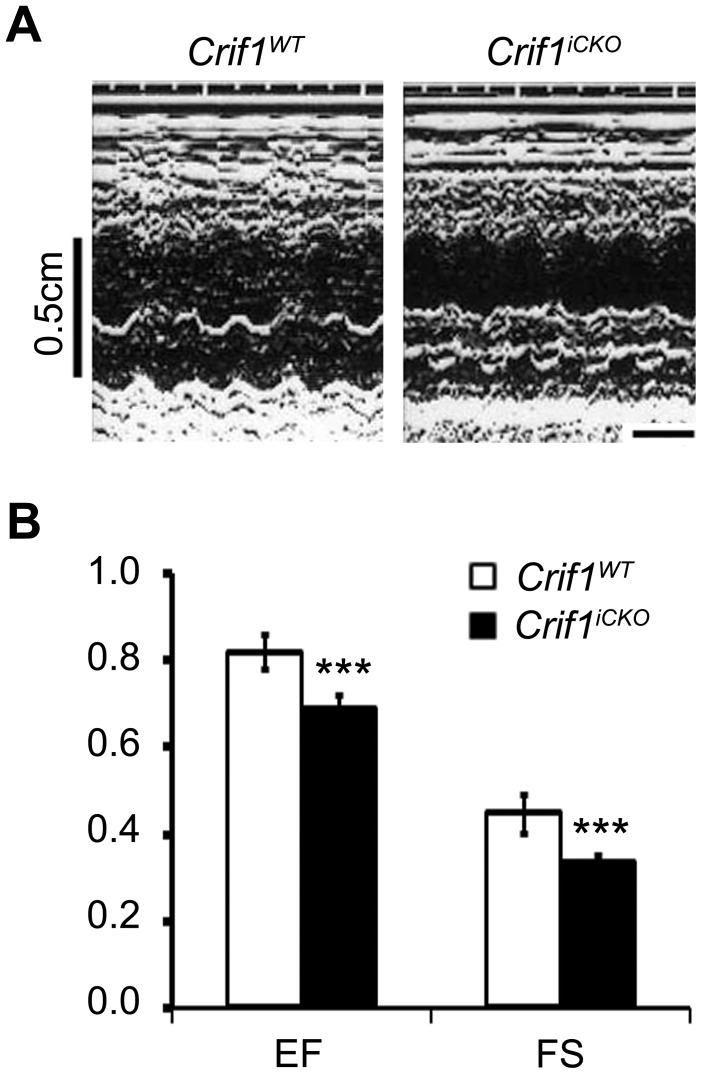
Crif1 loss impairs in vivo heart function.(A) Echocardiographic tracings of Crif1WT and Crif1iCKO mice at 4 months post tamoxifen injections. Scale bar = 0.1 sec. (B) Values of ejection fraction (EF) and fractional shortening (FS) obtained from echocardiography. n = 8 for Crif1WT and n = 11 for Crif1iCKO mice. Error bars show SD. ***
P<0.0001.